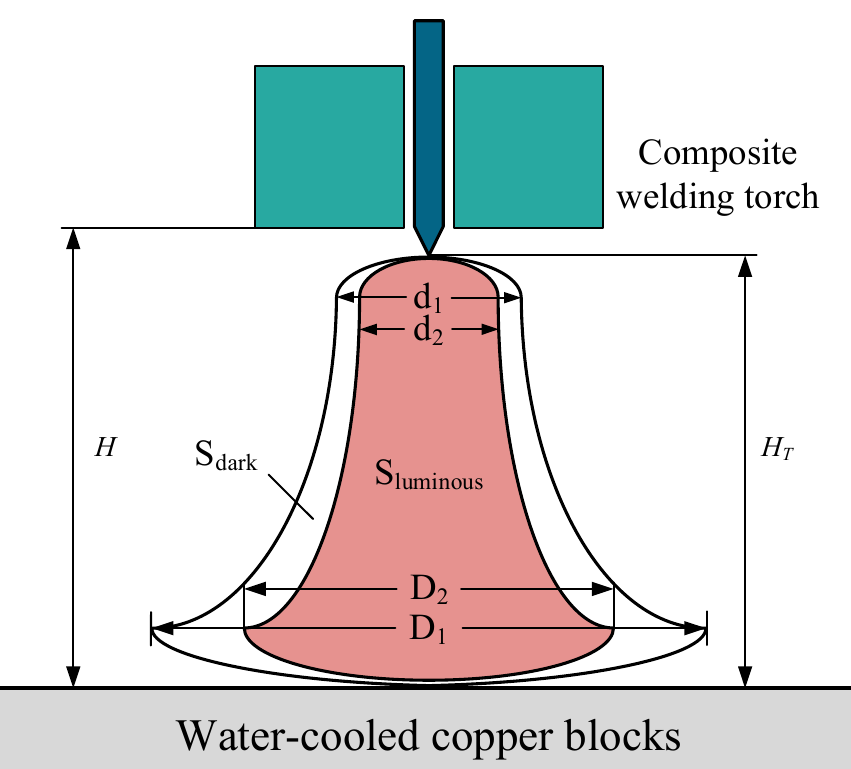
Figure 3. The arc parameter diagram.